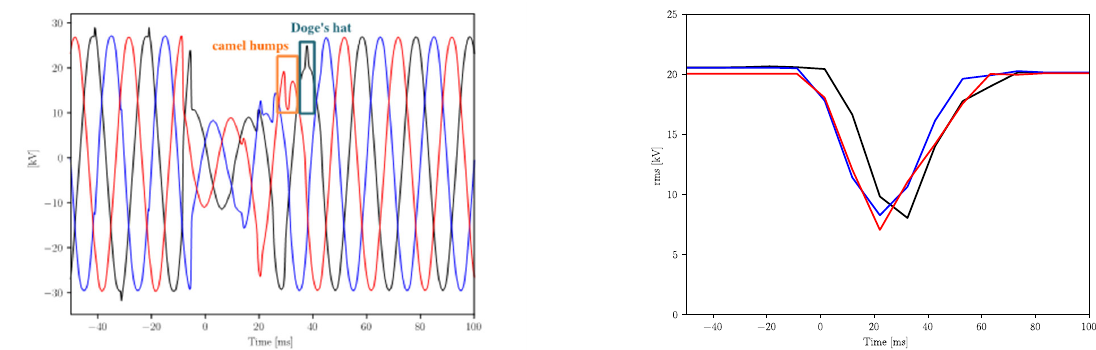
Figure 15. A false event due to VTs saturation: voltage waveforms with the characteristic “camel humps” and “Doge’s hat” patterns ( left ) and RMS voltage values ( right ).